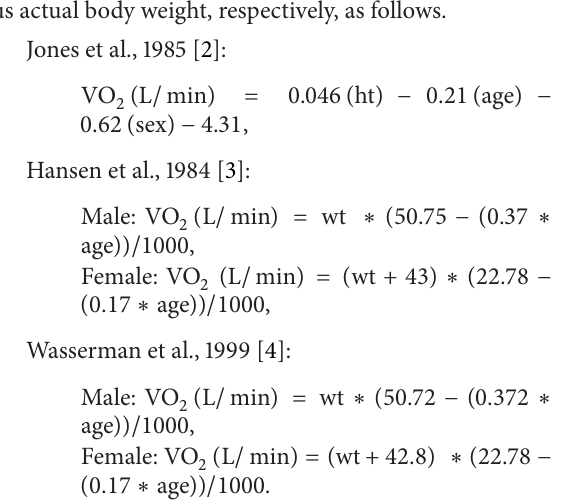
Table 1: Demographics gender variations.